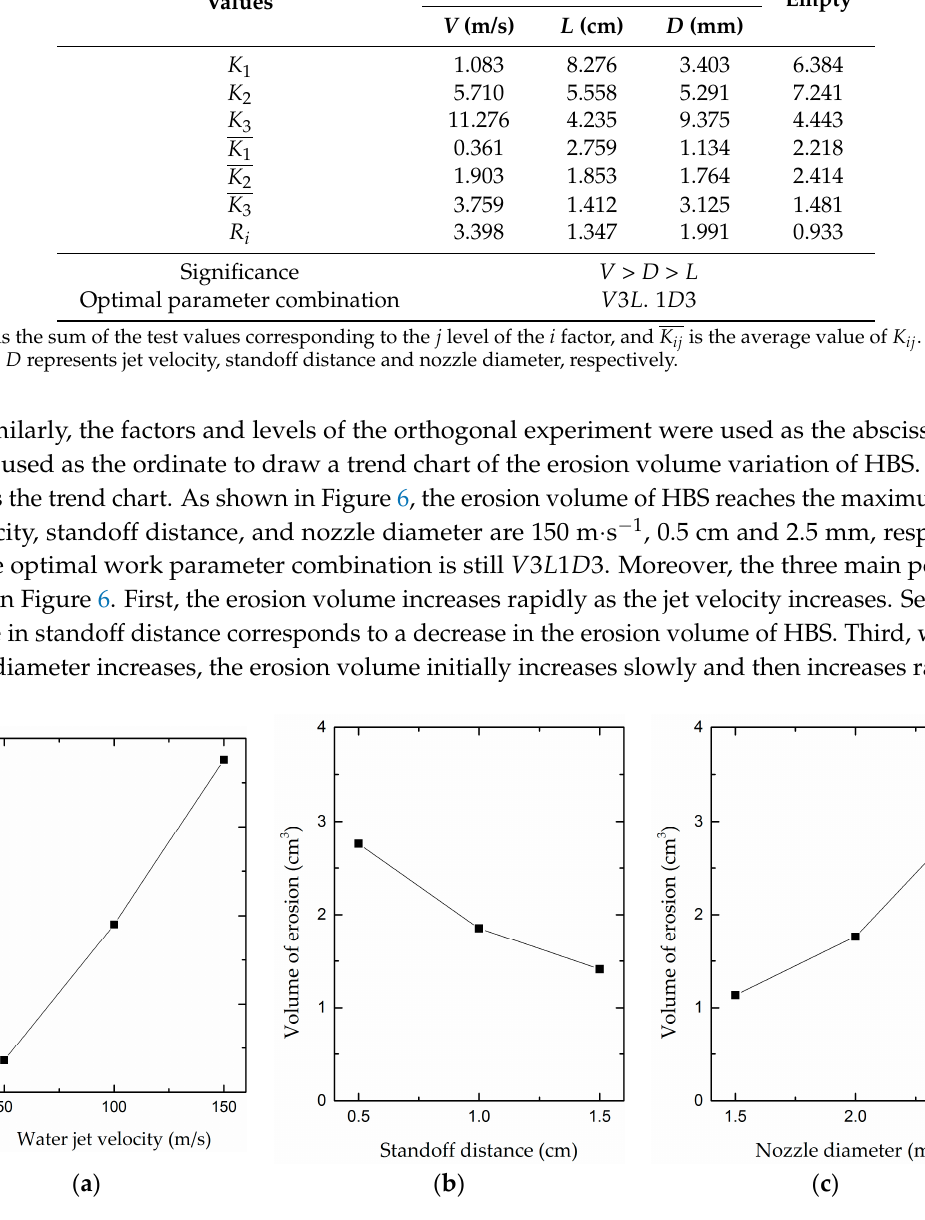
Figure 6. Trend chart of the erosion volume variation of HBS. ( a ) Water jet velocity; ( b ) standoff distance; ( c ) nozzle diameter.